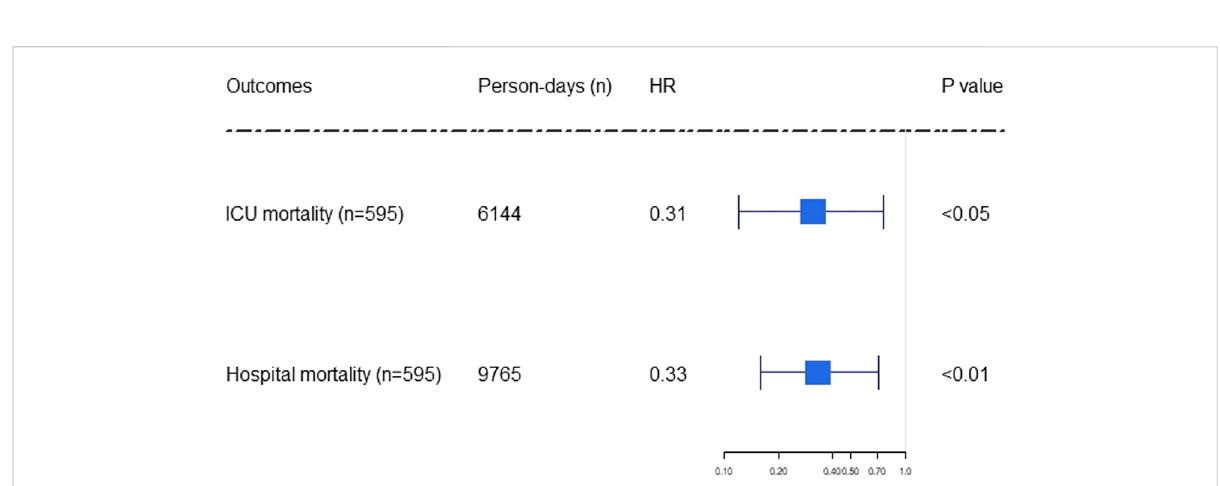
FIGURE 2 Forest plot showing the effect of sodium bicarbonate infusion on ICU and hospital mortality in elderly septic patients and acute moderate metabolicacidosis.ThehazardratioswereestimatedusingthemarginalstructuralCoxmodel.Person-dayswerethedaysofICUandhospitallength of stay. The x -axis tick marks follow a logarithmic scale. HR: hazard